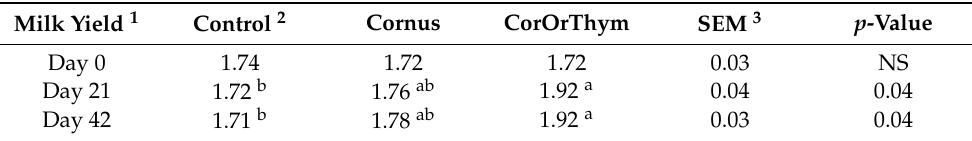
Table 5. Effects of diet supplementation with cornus extract and oregano and thyme essential oils on milk yield.